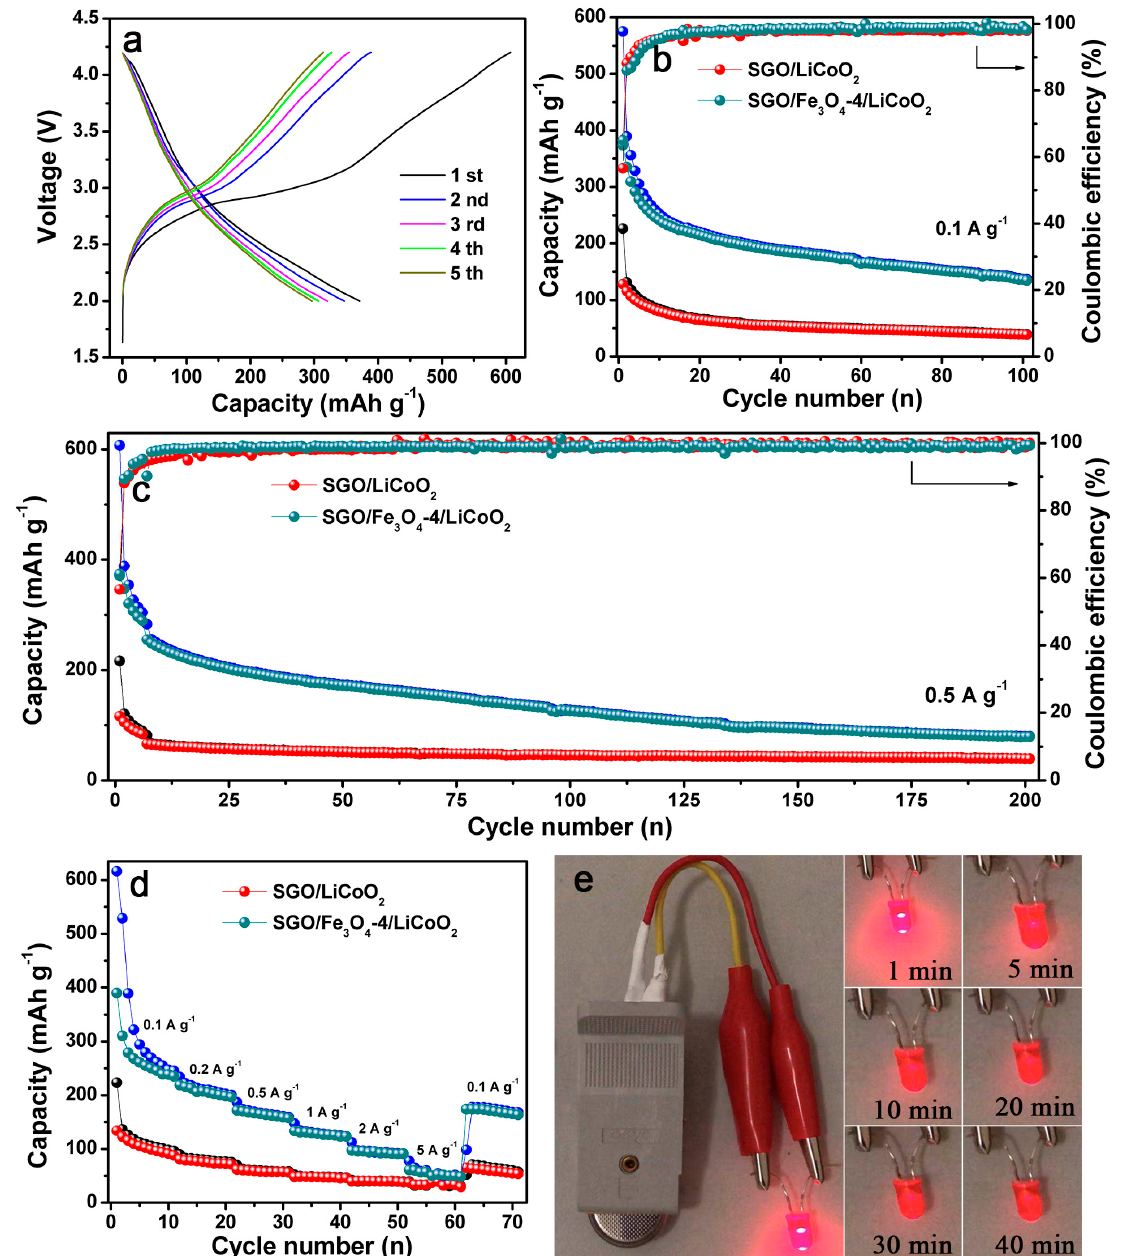
Figure 7. ( a ) Galvanostatic discharge/charge curves of the SGO/Fe 3 O 4 -4/LiCoO 2 full cell between 2 V and 4.2 V at 0.1 A g − 1 , ( b , c ) cycling performance comparison of the SGO/LiCoO 2 and SGO/Fe 3 O 4 -4/LiCoO 2 full cells at 0.1 A g − 1 and 0.5 A g − 1 , respectively, ( d ) rate capability and ( e ) picture of light-emitting diode (LED) powered by the assembled SGO/Fe 3 O 4 -4/LiCoO 2 full cell.